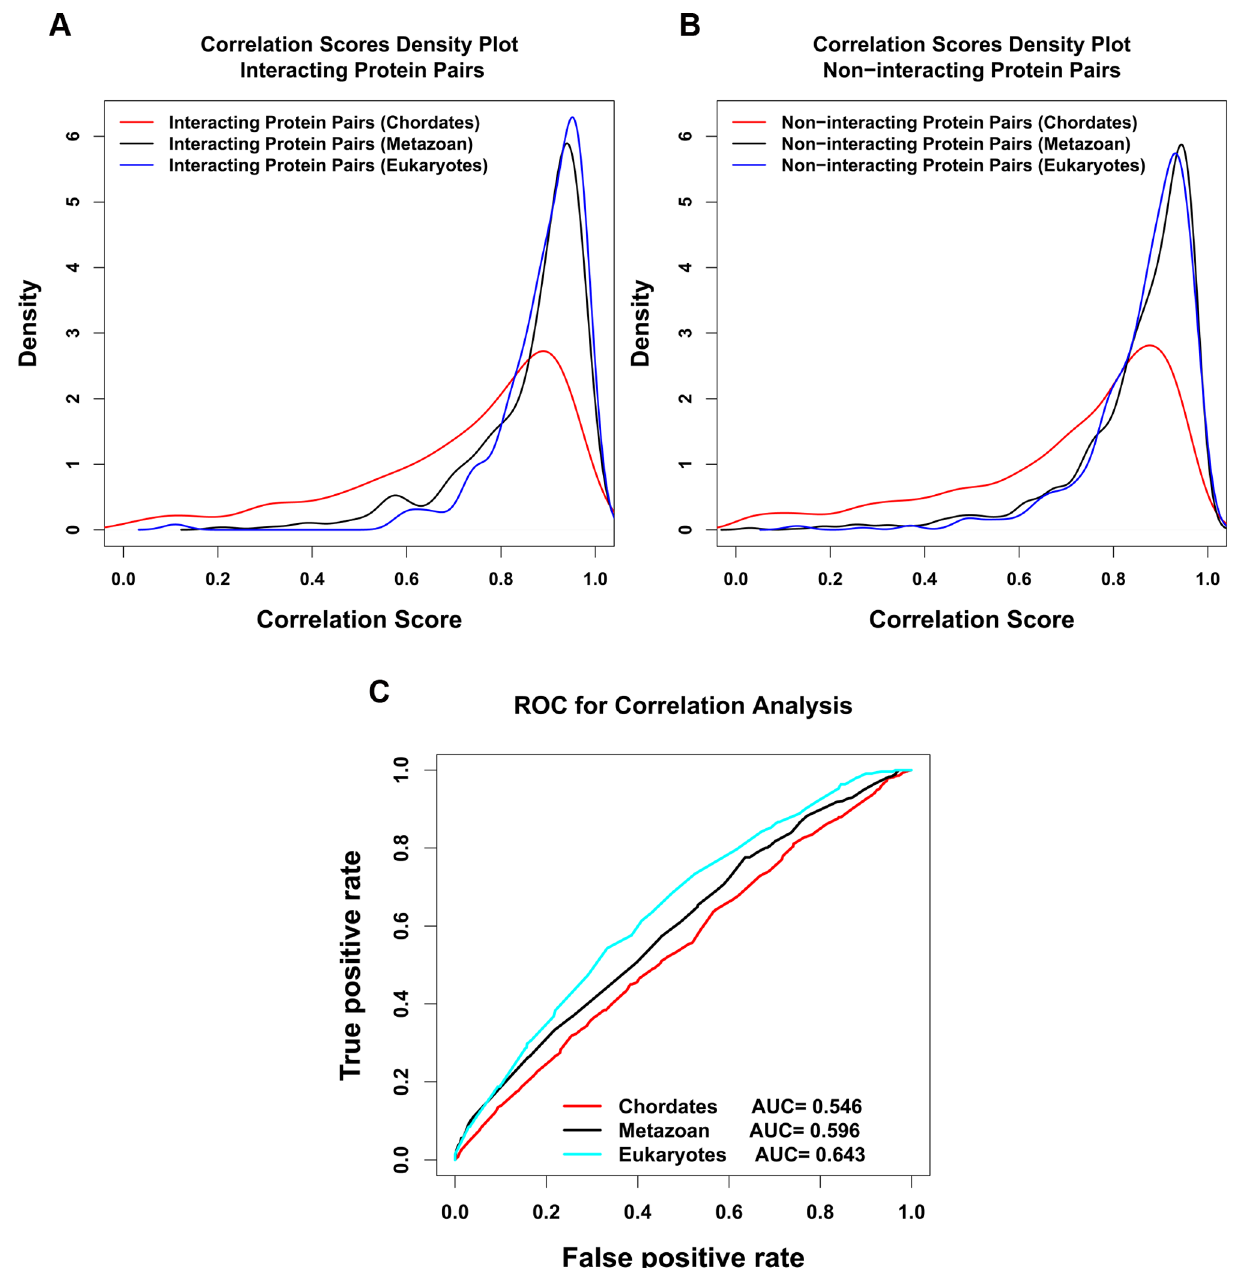
Figure 7. Correlation density plot for interacting (A) and non-interacting (B) Protein pairs of different evolutionary span from Dataset 3. In this plot we separately consider the protein pairs that are conserved only in chordates, the pairs that are conserved across the metazoan but not elsewhere in the eukaryotes, and finally the protein pairs that are distributed across the eukaryotes beyond the metazoan. C). The corresponding ROC plots for the correlation analysis for these 3 different